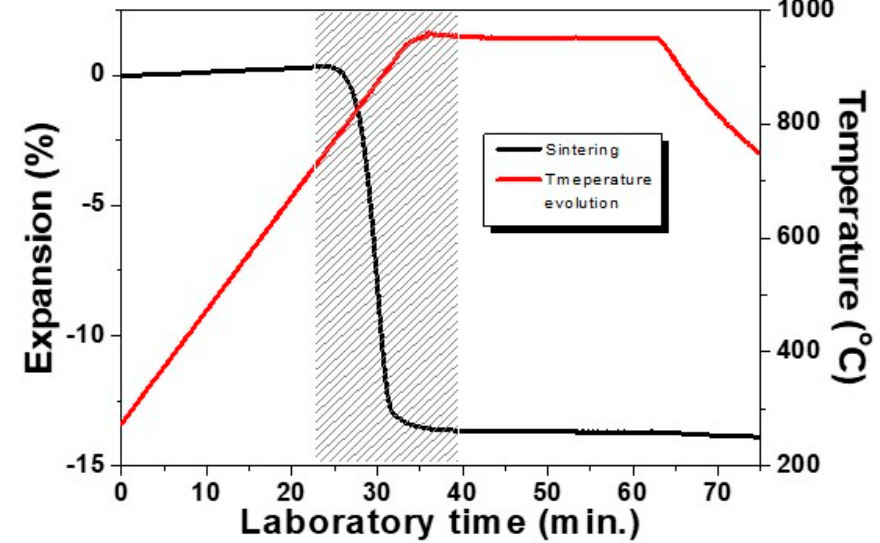
Figure 2. Sintering curve of glass–ceramic sample revealed by HSM.